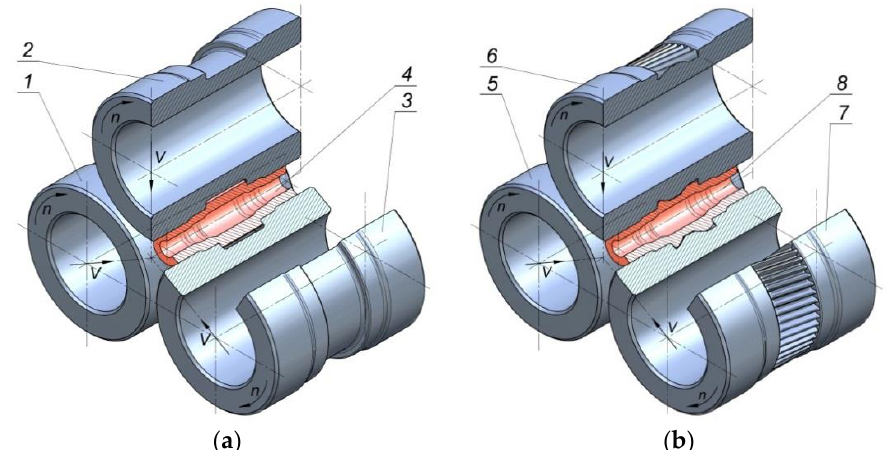
Figure 1. Schematic design of the rotary compression of a hollow stepped gear shaft: ( a ) Operation 1—formation of a shaft with smooth steps, ( b ) Operation 2—formation of a gear; 1, 2, 3–tools used in Operation 1, 4—stepped shaft, 5, 6, 7—tools used in Operation 2, 8—hollow stepped shaft with a gear.